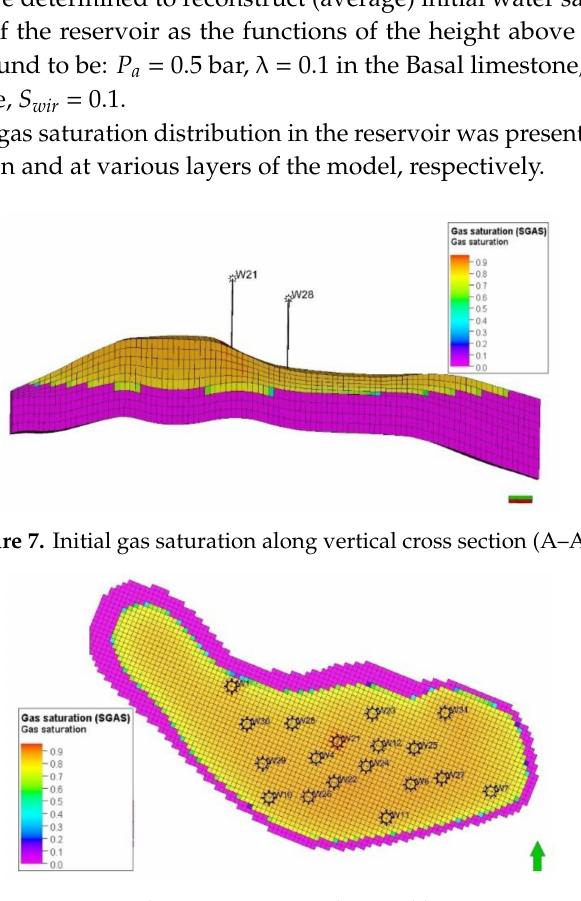
Figure 8. Initial gas saturation at the Basal limestone top.